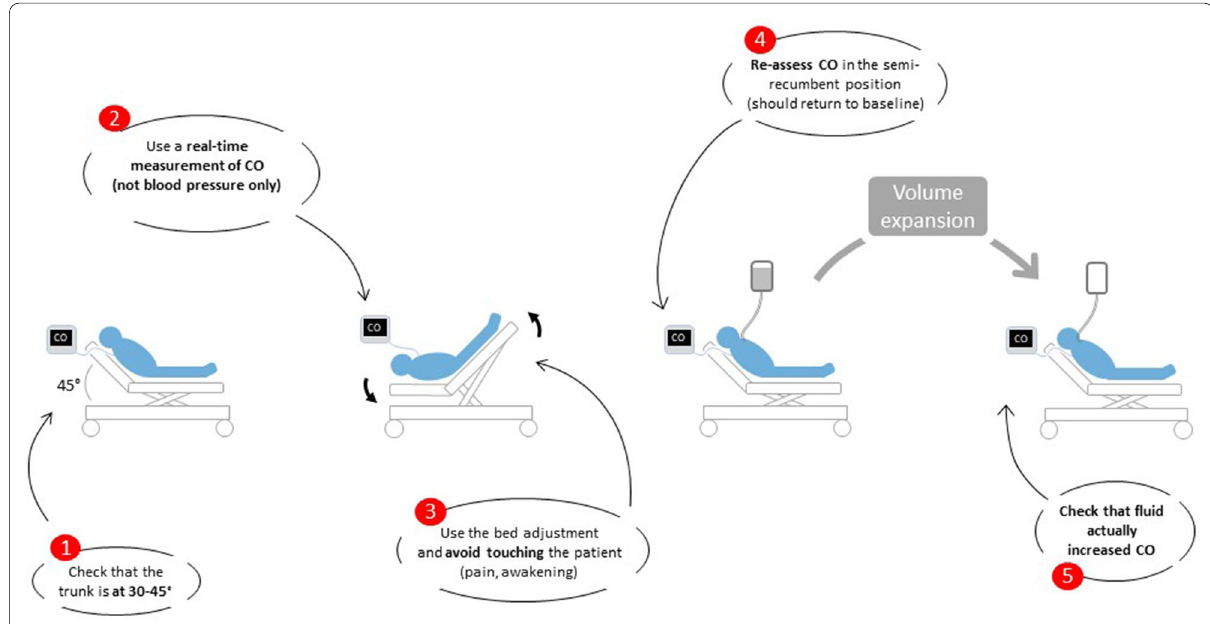
Fig. 1 Practical rules for performing passive leg raising. CO cardiac